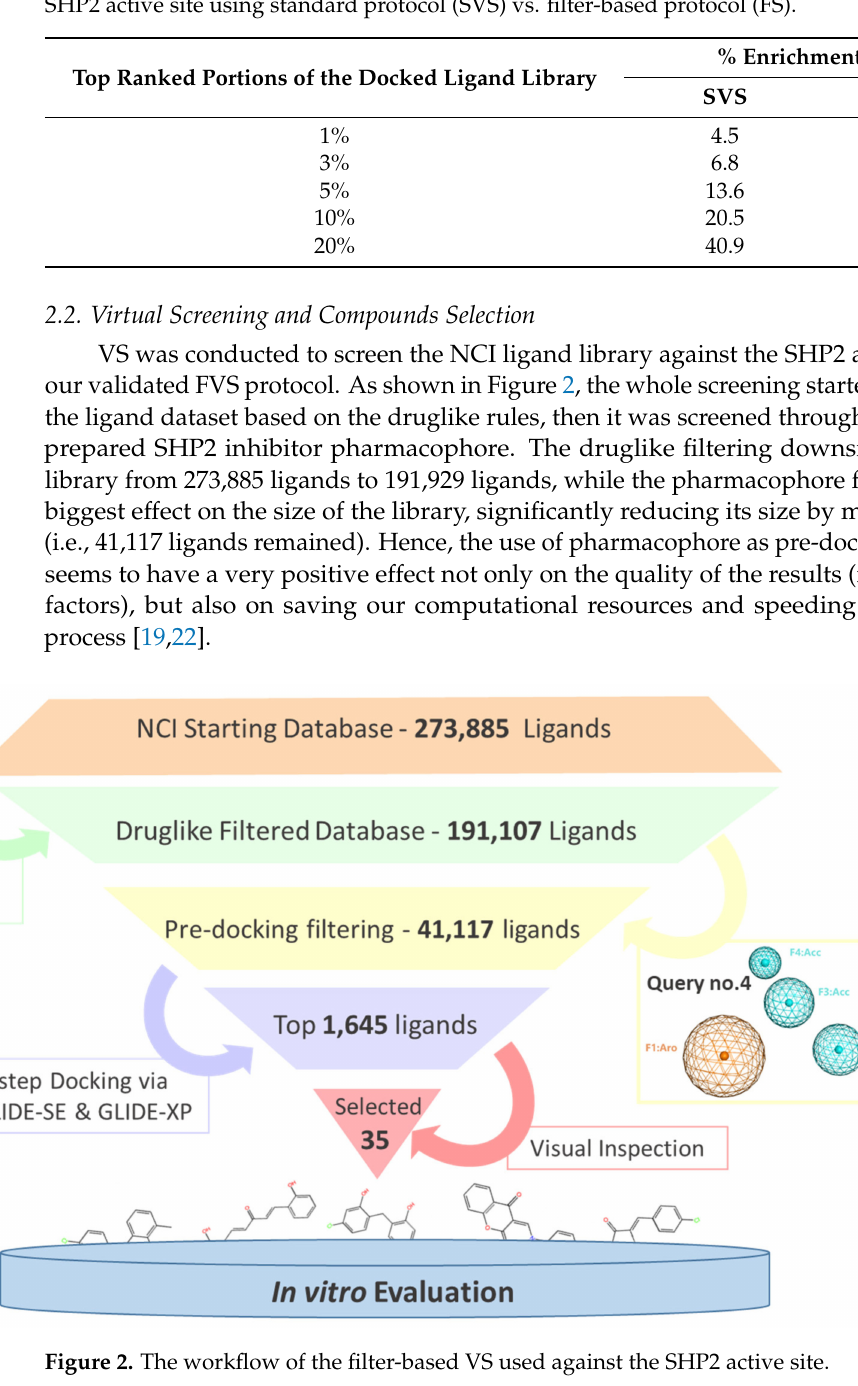
Figure 2. The workflow of the filter-based VS used against the SHP2 active site. Consequently, the final ligand dataset was docked into the SHP2 active site in a three- step process, where precision and docking accuracy increased with time. These three steps were conducted via the HTVS, SP, and XP mode in the GLIDE docking software. The